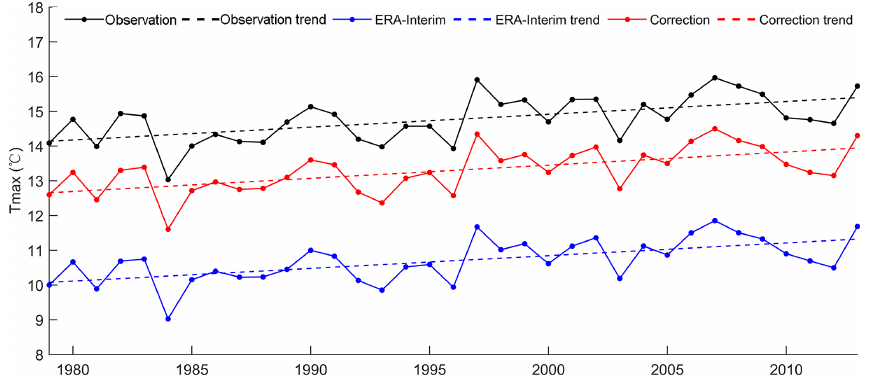
Figure 10. Temporal variations of T max from observation, original ERA-Interim, and correction temperatures for the 24 sites in 1979–2013.